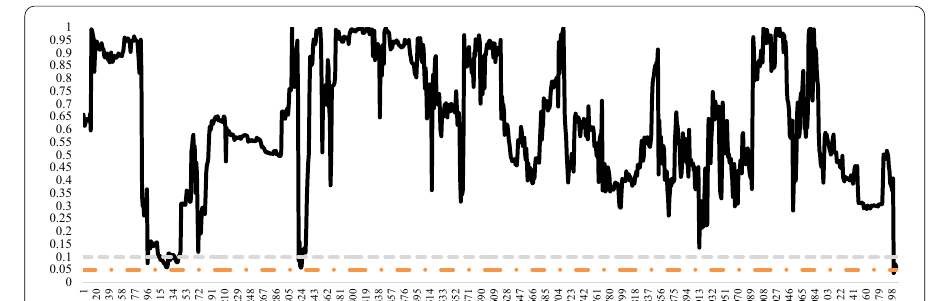
Fig. 7 The evolving p values of the AQ test statistic checked for Bitcoin (BTC) in 150-day window length